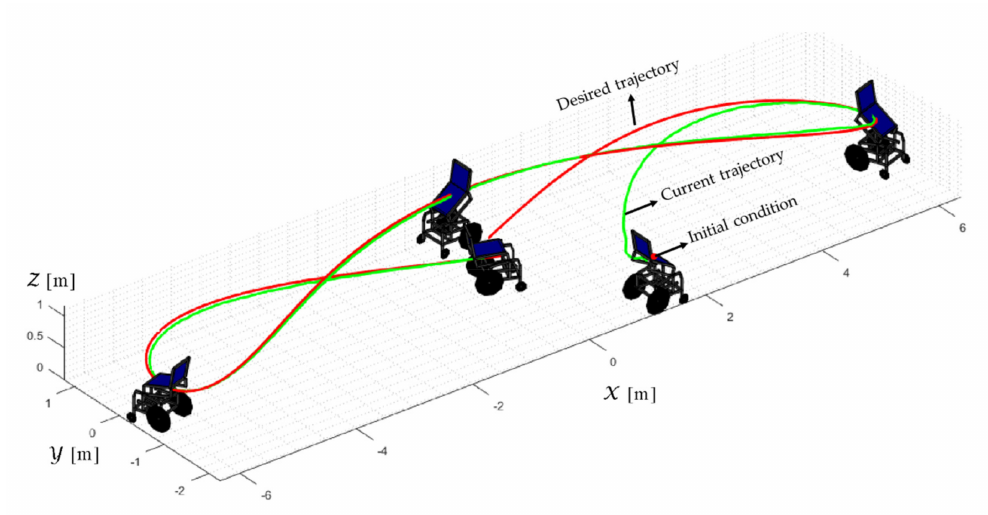
Figure 24. Stroboscopic movement of the human–robot system based on the real experimental data.